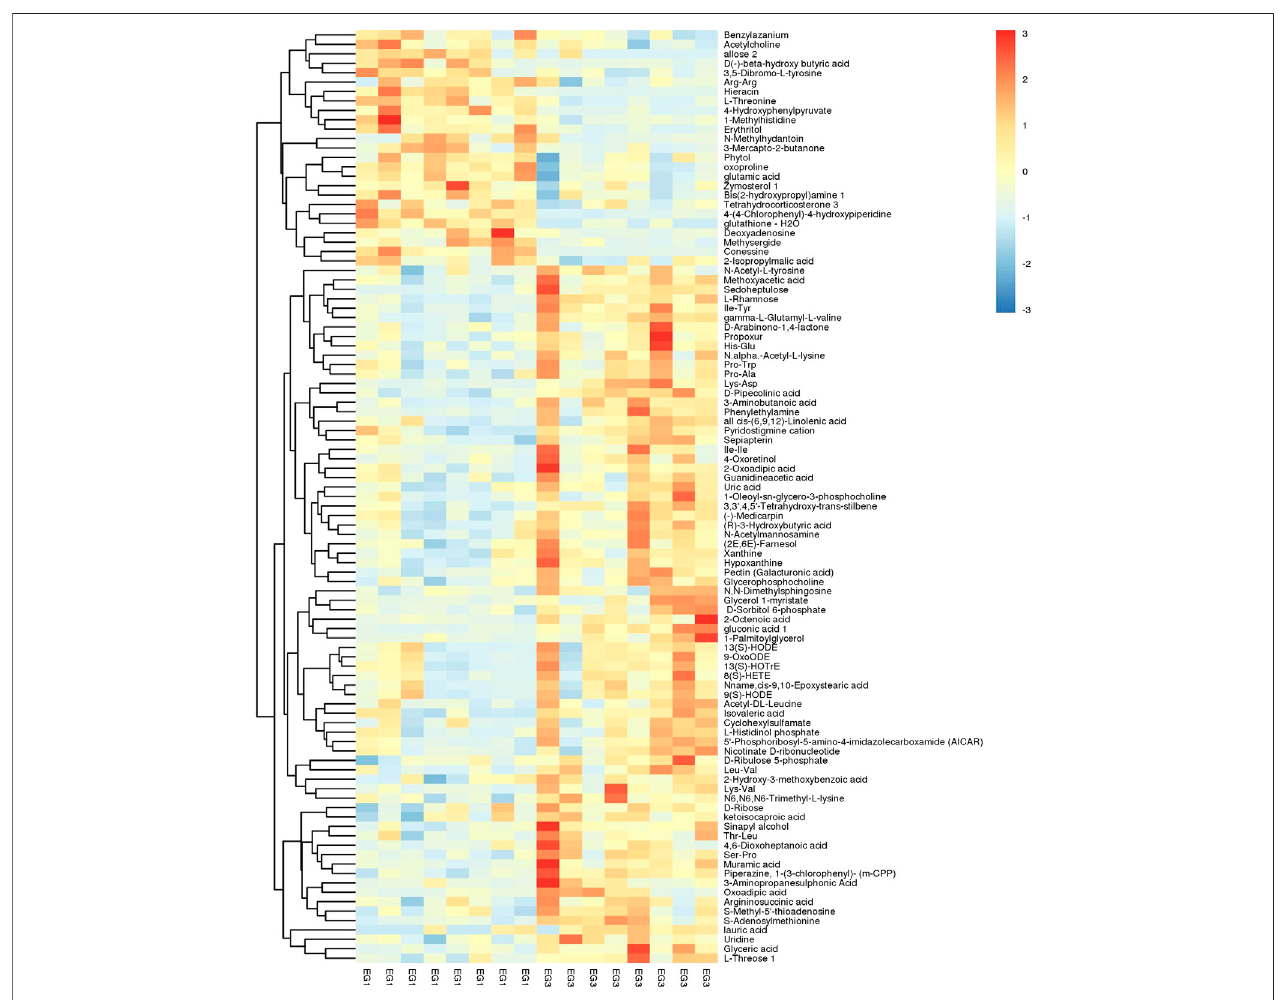
FIGURE2 | Hierarchical clusteringanalysison SDMs. The relative metabolite level is depicted according tothe color scale. Red and blue indicate upregulation and downregulation, respectively.